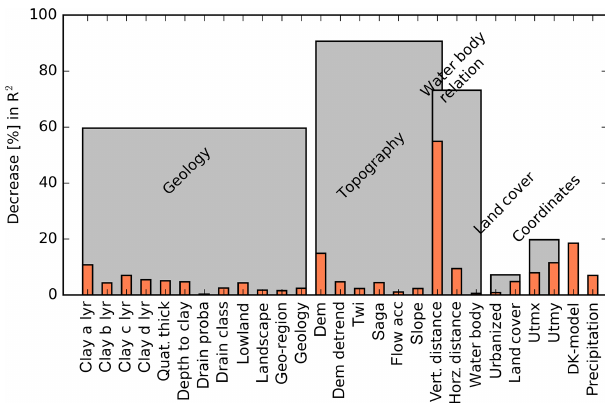
Figure 5. Variable importance of the trained RF model. The concept of permutation accuracy was implemented to quantify the decrease in out-of-bag performance R 2 . Permutation was applied not only to single covariates (orange) but also to groups of covariates (grey). Covariates are further specified in Table